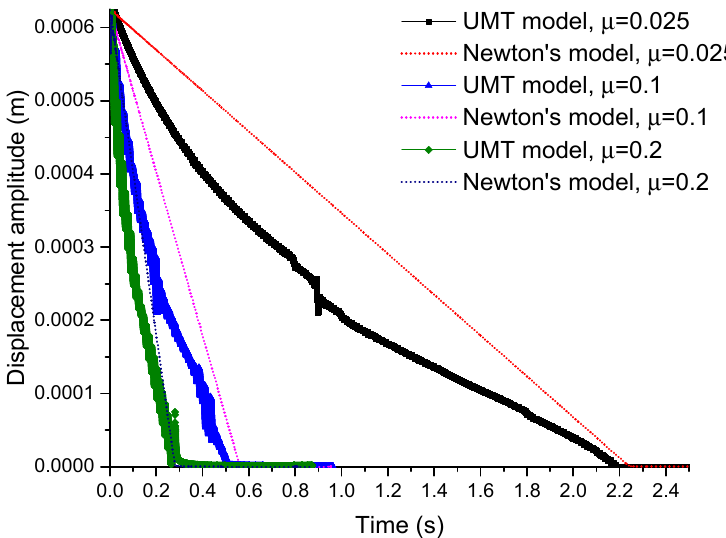
Figure 7. Amplitude versus time for various values of frictional coefficients.